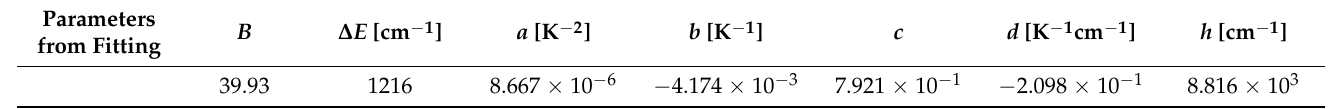
Table 1. The parameters obtained by fitting experimental results to Equations